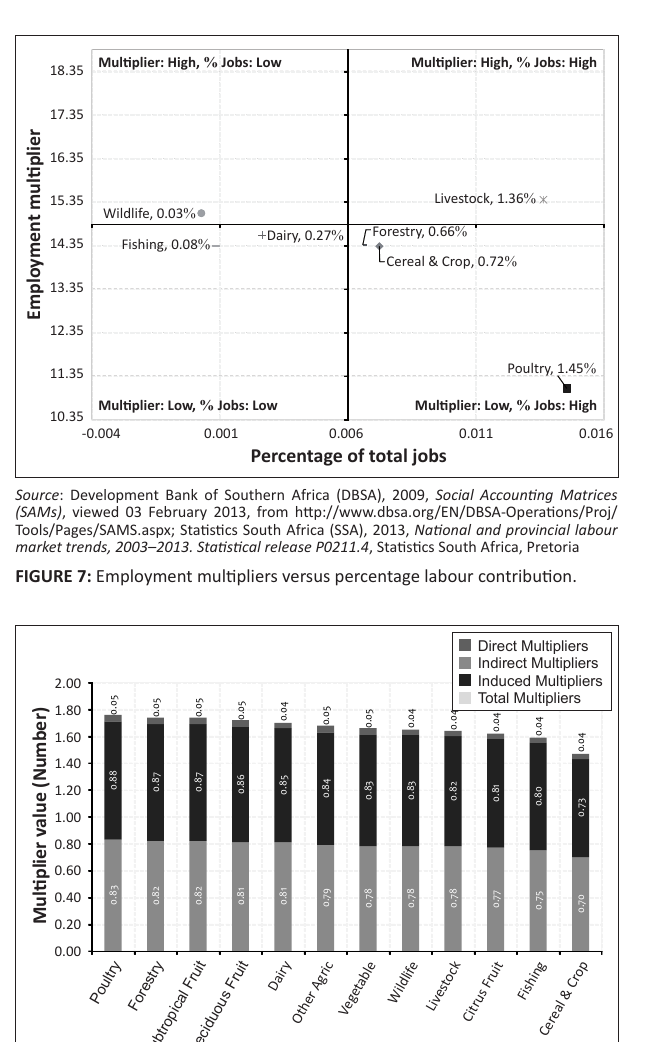
FIGURE 9: Household Income multipliers versus percentage labour contribution.